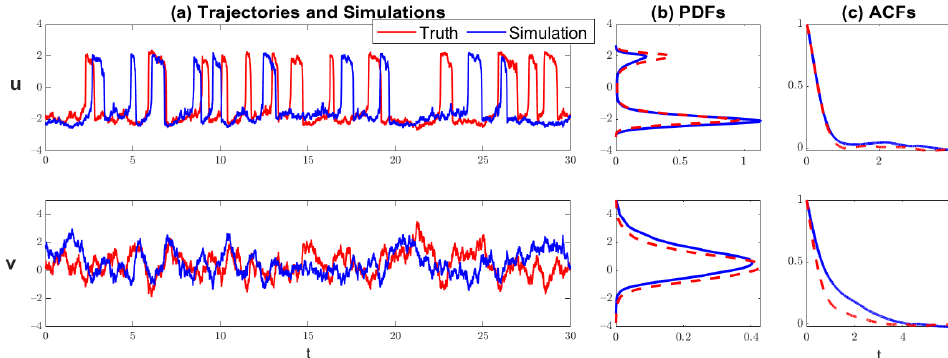
Figure 7. Similar to Figure 6 but for dynamical regime